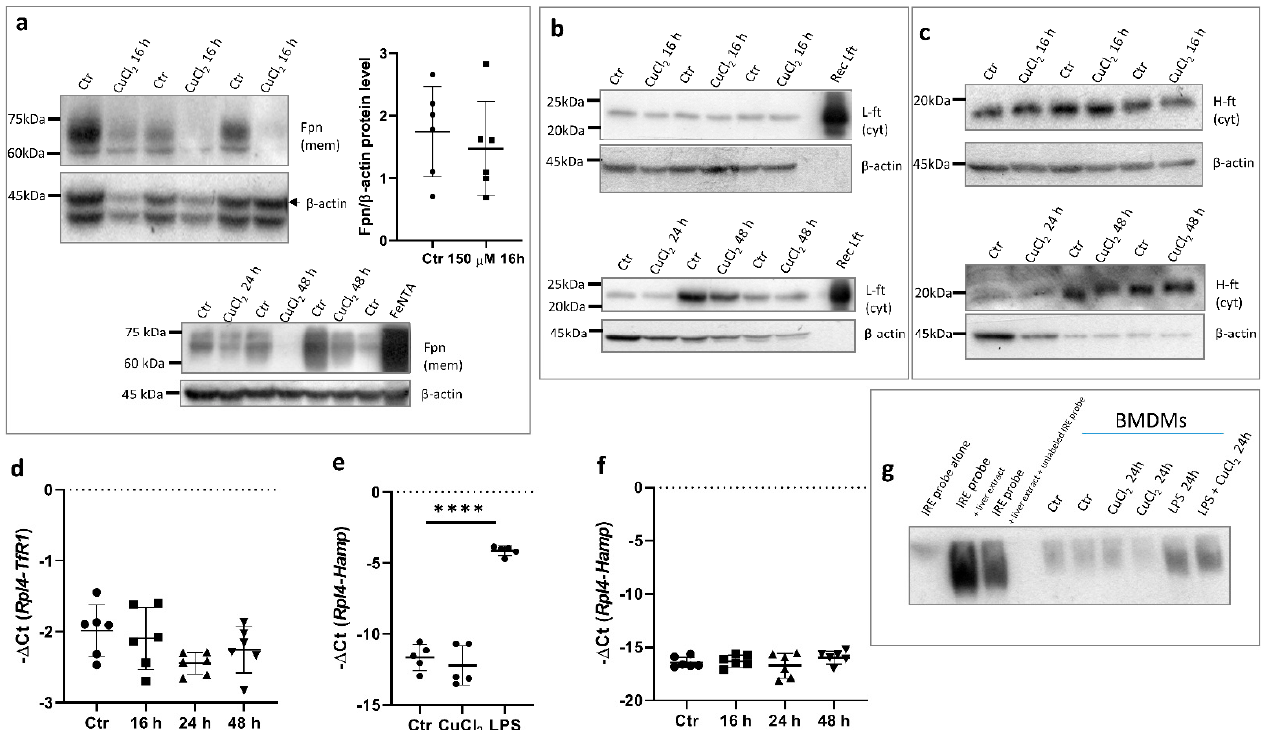
Figure 4. Copper loading decreases Fpn protein levels in hepcidin- and IRE-independent manner. ( a ) Upper panel: Western blot analysis of Fpn protein level in membrane fraction of control cells and BMDMs treated with 150 μ M CuCl 2 for 16 h. Graph illustrates densitometric analysis of Fpn protein level normalized to β -actin level from 6 independent experiments. Bottom panel: Western blot analysis of Fpn protein level in membrane fraction of control cells and BMDMs treated with 150 μ M CuCl 2 for 24 and 48 h. BMDMs stimulated with 150 μ M FeNTA were used as positive controls to check specificity of antibody. ( b ) Western blot analysis of L-ferritin protein level in cytosolic fraction of control cells and 150 μ M CuCl 2 -treated BMDMs. Recombinant mouse ferritin light chain (Rec L-Ft) was used as positive control. ( c ) Western blot analysis of H-ferritin protein levels in cytosolic fraction of control and 150 μ M CuCl 2 -treated BMDMs. ( d ) qPCR analysis of TfR1 mRNA expression in BMDMs incubated with 150 μ M CuCl 2 for 16, 24, and 48 h. Data represent mean ± SD. ( e ) qPCR analysis of Hamp expression in BMDMs incubated with 150 μ M CuCl 2 or 100 ng/mL lipopolysaccharide (LPS) for 16 h. Data represent mean ± SD, **** p < 0.0001. ( f ) qPCR analysis of Hamp mRNA expression in BMDMs incubated with 150 μ M CuCl 2 for 16, 24, and 48 h. Data represent mean ± SD. ( g ) RNA-EMSA was performed to assess IRE-IRP binding activity in BMDMs treated with 150 μ M CuCl 2 or 200 ng/mL LPS for 24 h. Cytosolic extract (20 μ g) from BDMDs was incubated with biotinylated IRE probe, and RNA-protein complexes were separated on non-denaturing polyacrylamide gel. Biotin-IRE control RNA, biotin-IRE control RNA + cytosolic extract from liver (5 μ g), and biotin-IRE control RNA + cytosolic extract from liver (5 μ g) + 200-fold molar excess of unlabeled IRE RNA were used as positive control reaction.